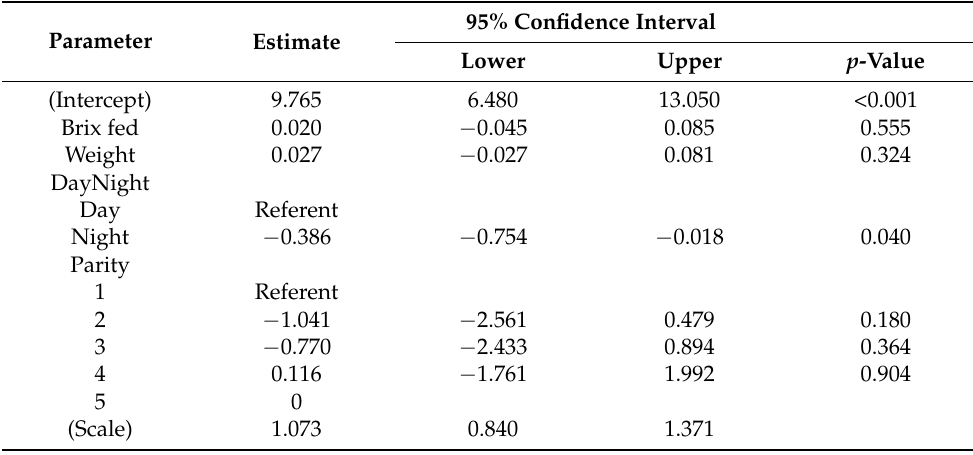
Table 5. Factors affecting serum Brix% of female Holstein